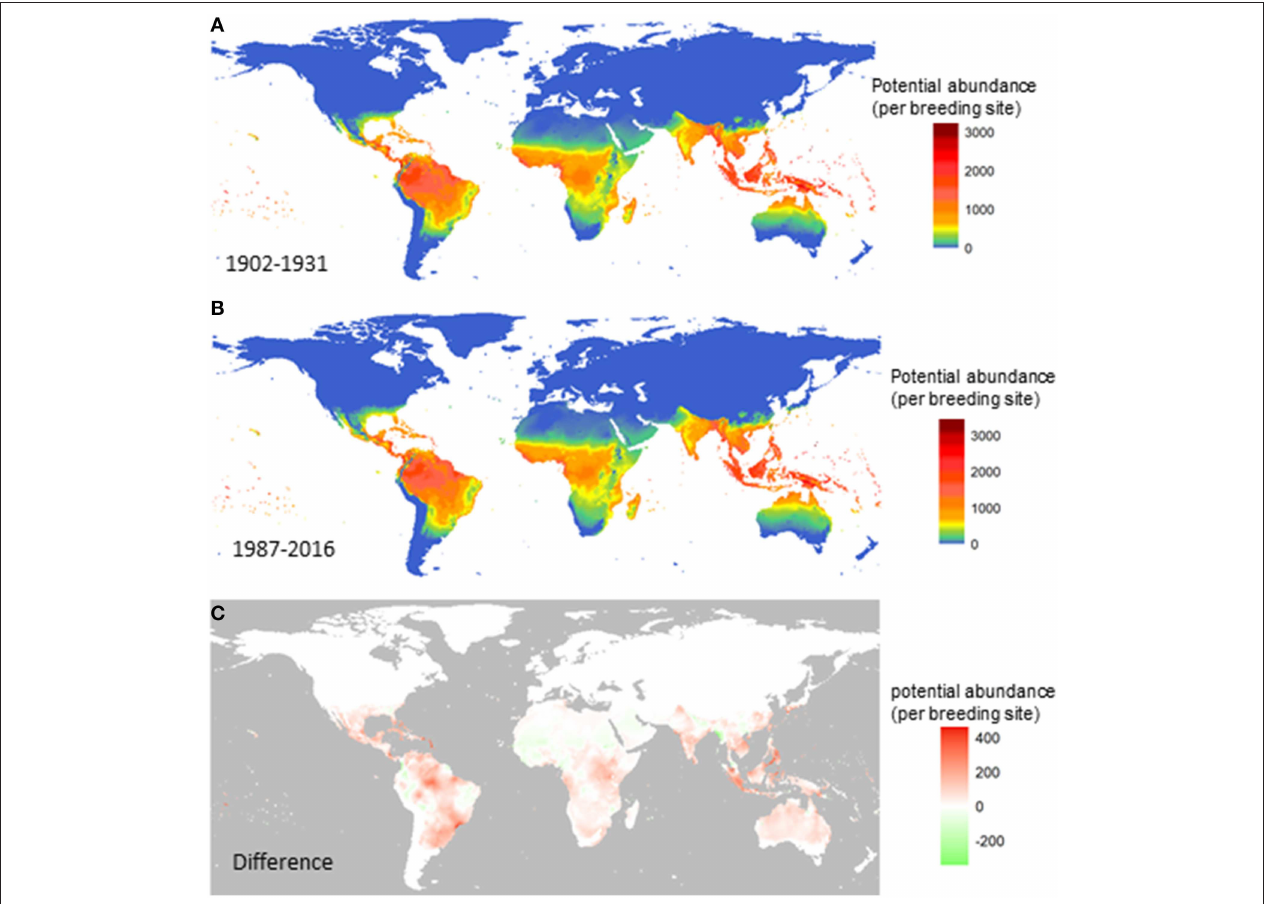
FIGURE 2 | Change in the potential abundance of Aedes aegypti (per larval site) over the 20th century. The female vector population was first summarized for each year and then averaged over three decades at the beginning of the last century (A) , the turn of this century (B) . The difference between (B) and (A) is shown in (C) . Model A was